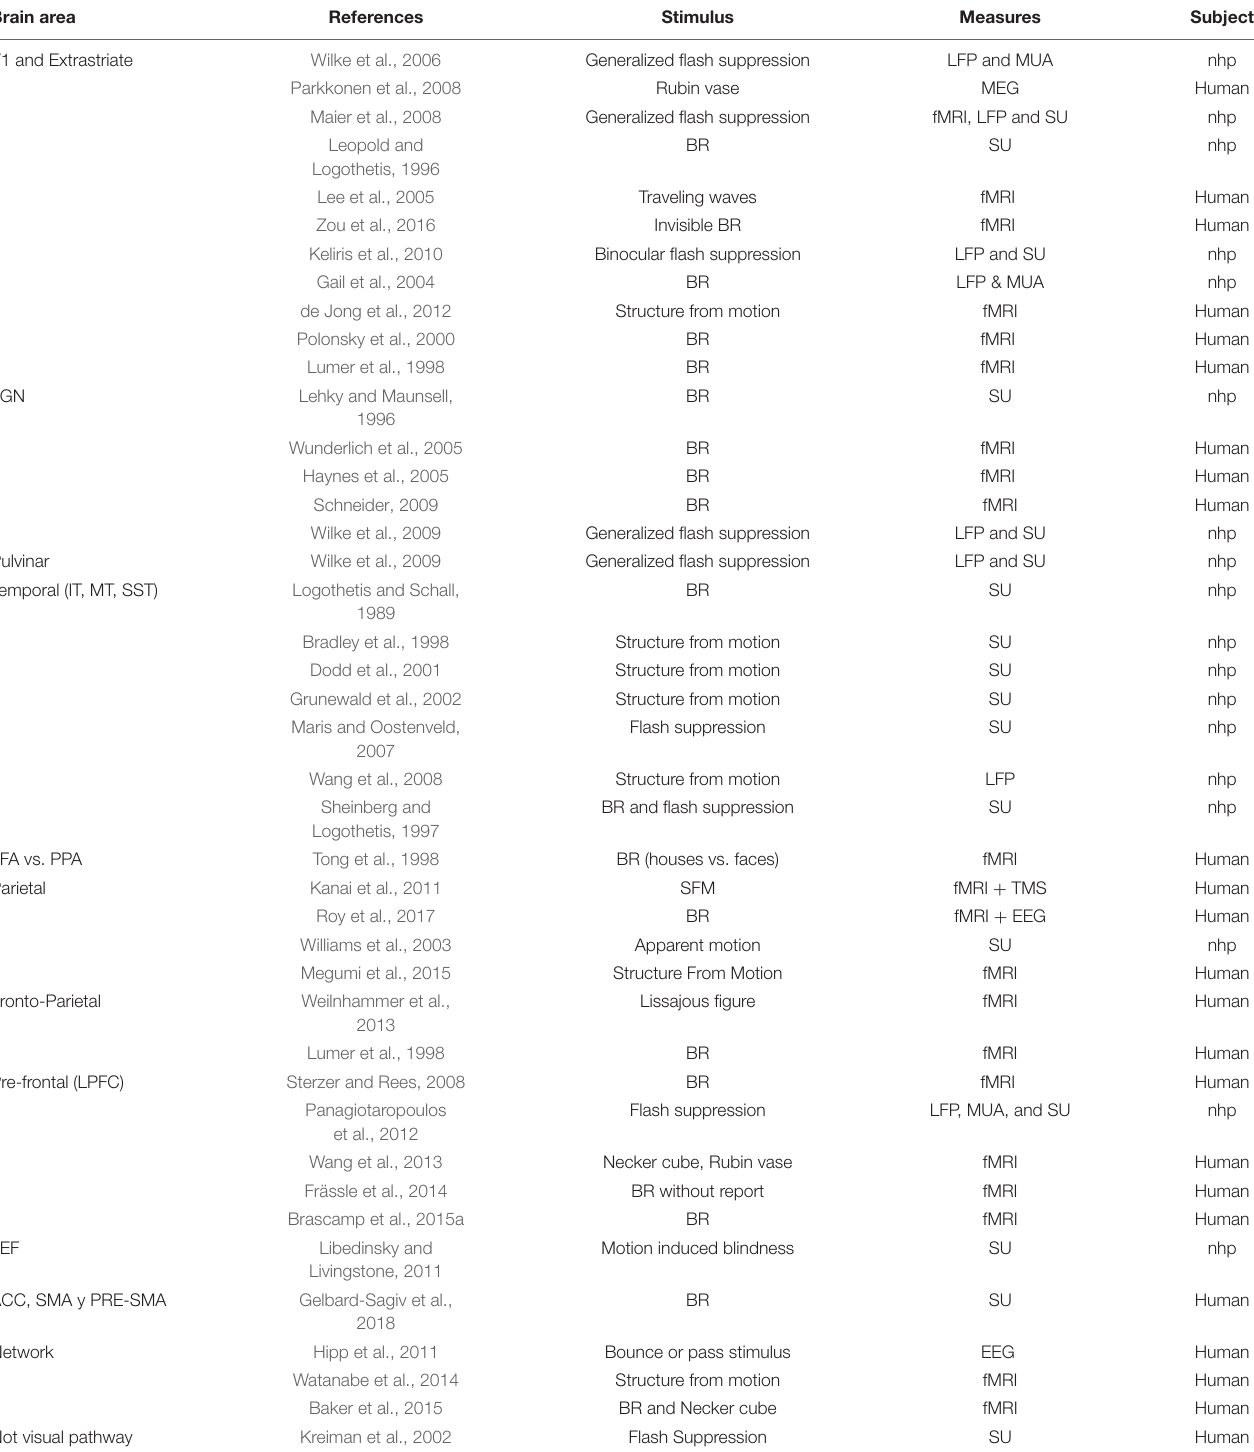
TABLE 2 | Brain areas from different organism are modulated by bi-stable stimuli. Brain